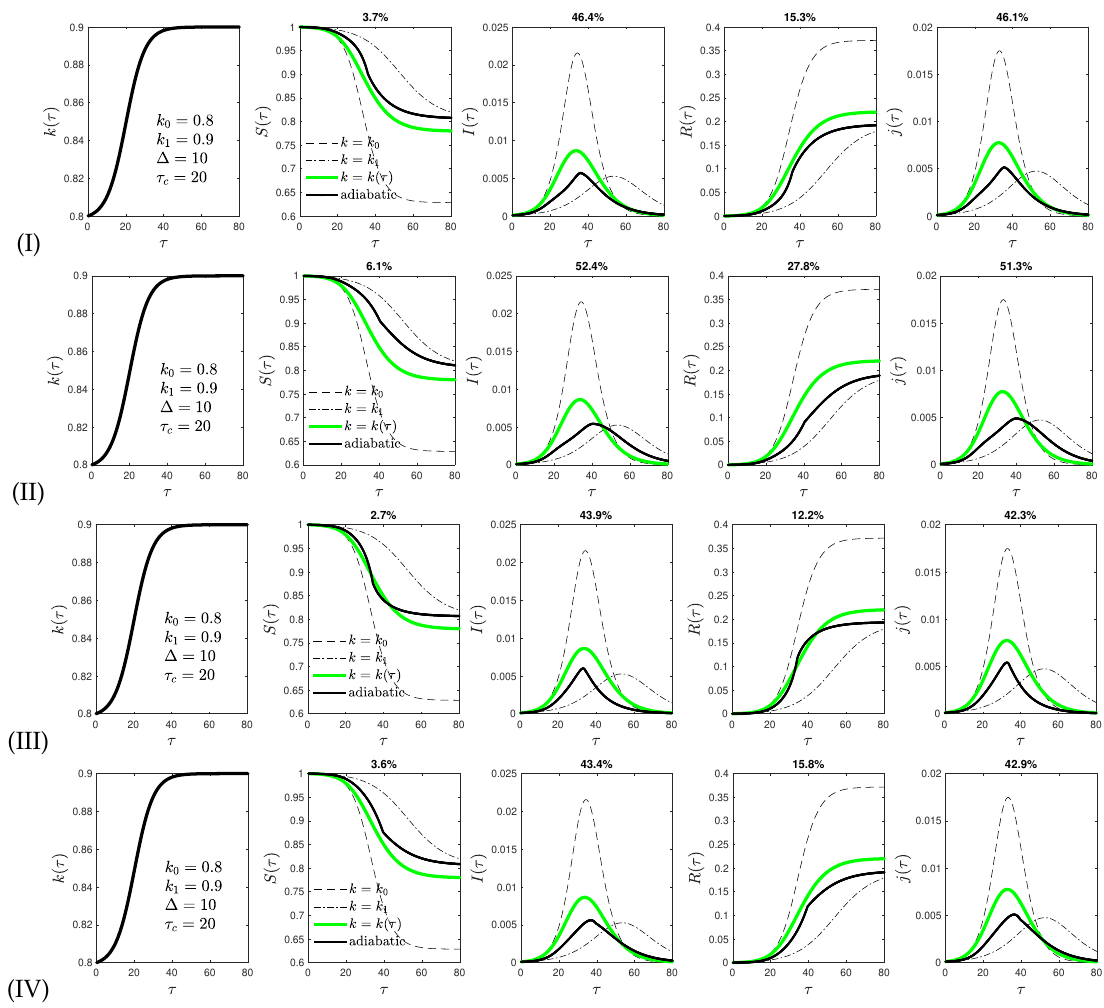
Figure 2. Results for versions I–IV of KSSIR model [8,9] with the dimensionless parameters of the ratio (6) as indicated in the most left panel, and η = 10 − 4 . The second, third, fourth and fifth (left to right) panels display the calculated dependence of the fractions of susceptible, S ( τ ) , infected, I ( τ ) , and recovered/removed, R ( τ ) , persons, and the rate of new infections, j ( τ ) (16), respectively, as a function of the reduced (dimensionless) time, τ . The green curve provides the exact numerical result, the solid black curve shows the adiabatic approximation, the dashed curve shows the KSSIR-variation adopting the initial ratio, k 0 , at all times, and the dot-dashed curve displays the KSSIR-variation adopting the final ratio, k 1 , at all times. The percentages on top of each panel indicate the maximum relative deviations between exact and approximate solutions. See text for